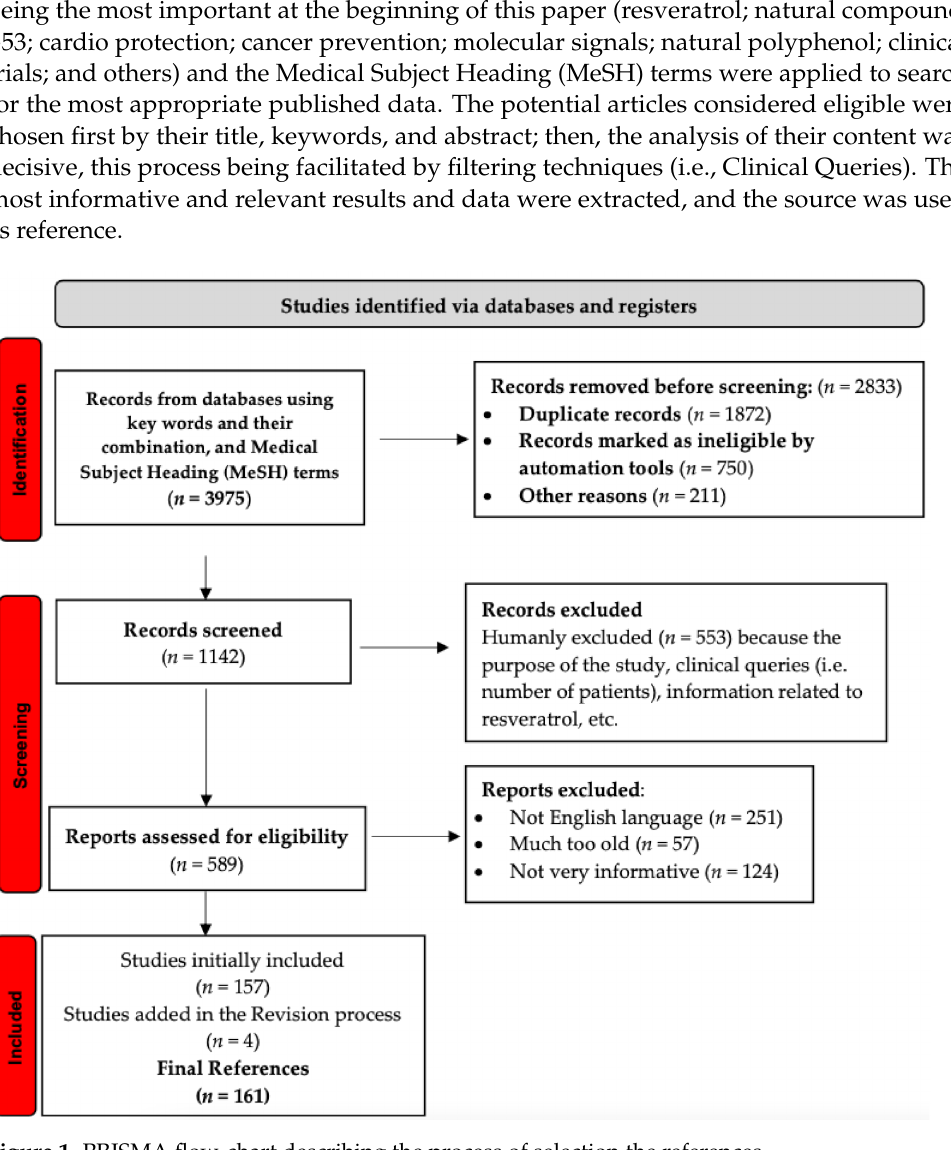
Figure 1. PRISMA flow-chart describing the process of selection the